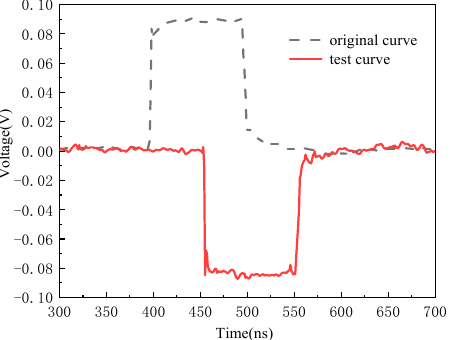
Figure 14. Time domain response of the sensor with the applied square wave is 8366 V/m. Figure 15 shows that the relation between electric field E and output voltage V out detected by the oscilloscope. As observed in Figure 15b, the measurable linear electric